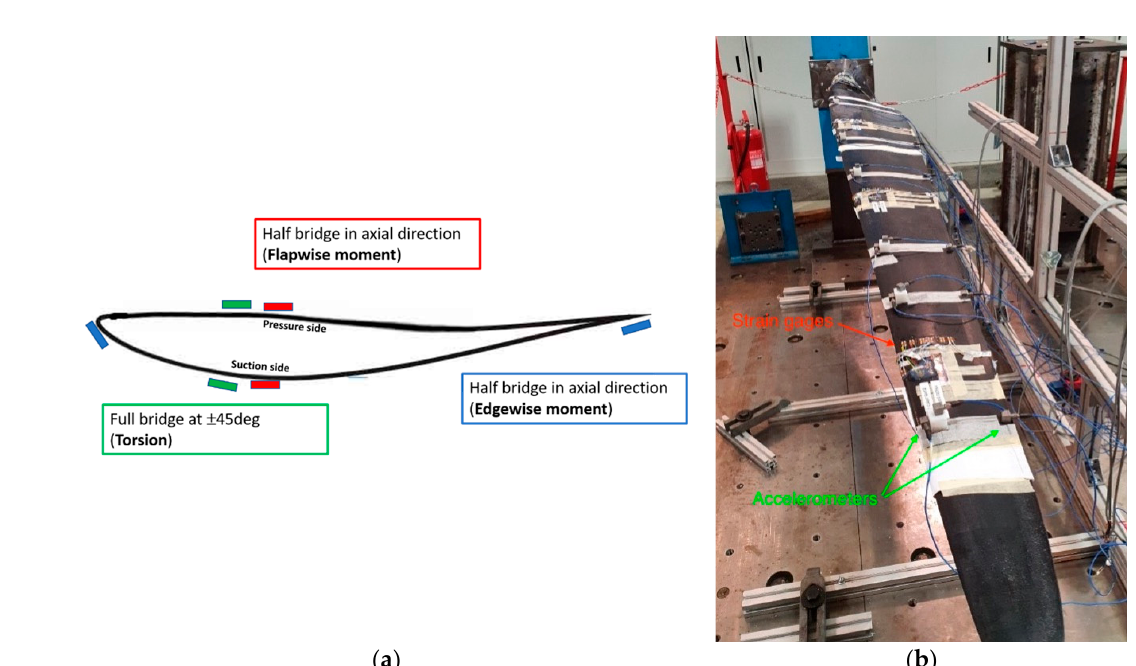
Figure 15. Schematic of the load-application mechanism ( a ). The blade static test bench ( b ).